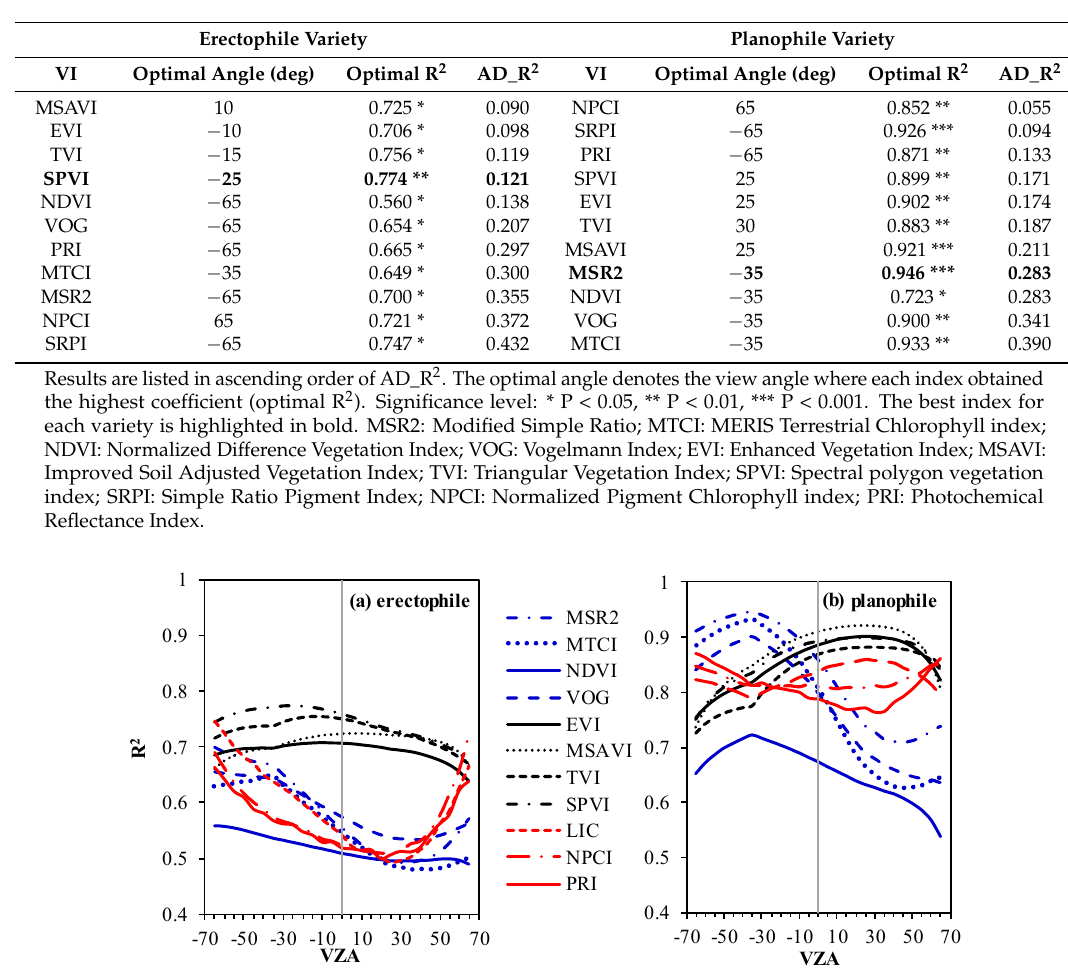
Table 4. The optimal angle and view angle sensitivity of linear correlation between each published VI listed in Table 2 and LAI based on measured datasets.